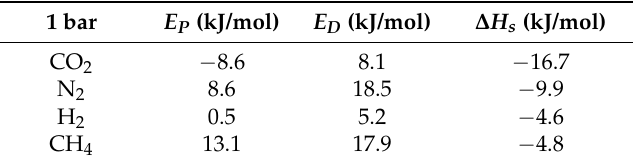
Table 6. Activation energies for gas permeation ( E p ), for diffusion ( E d ) and for sorption (Δ H s ) of PIM-